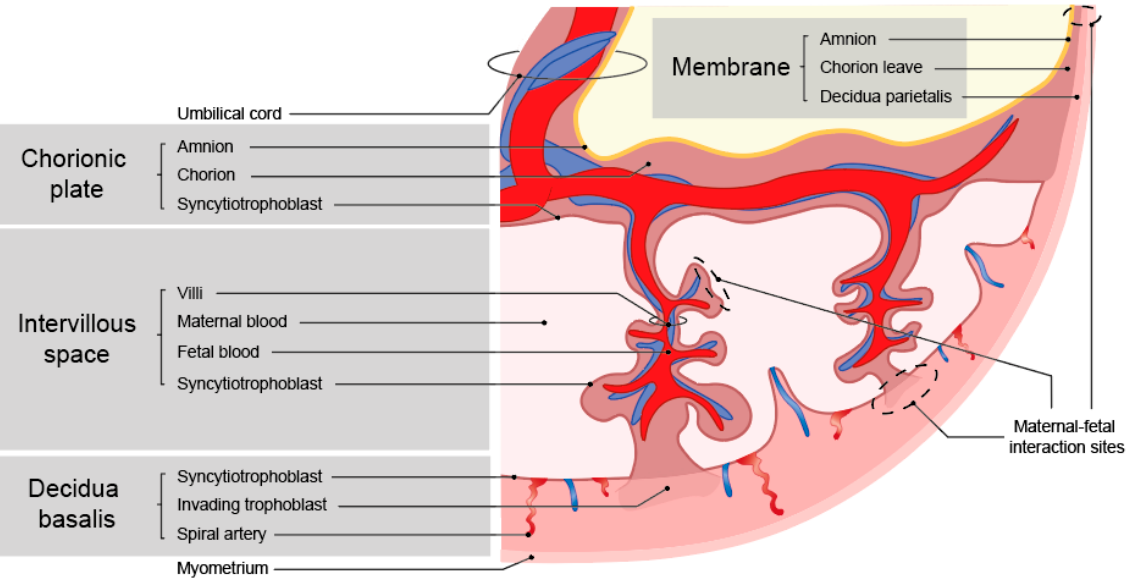
Figure 2. Overview of the structure of a term placenta and maternal-fetal interaction